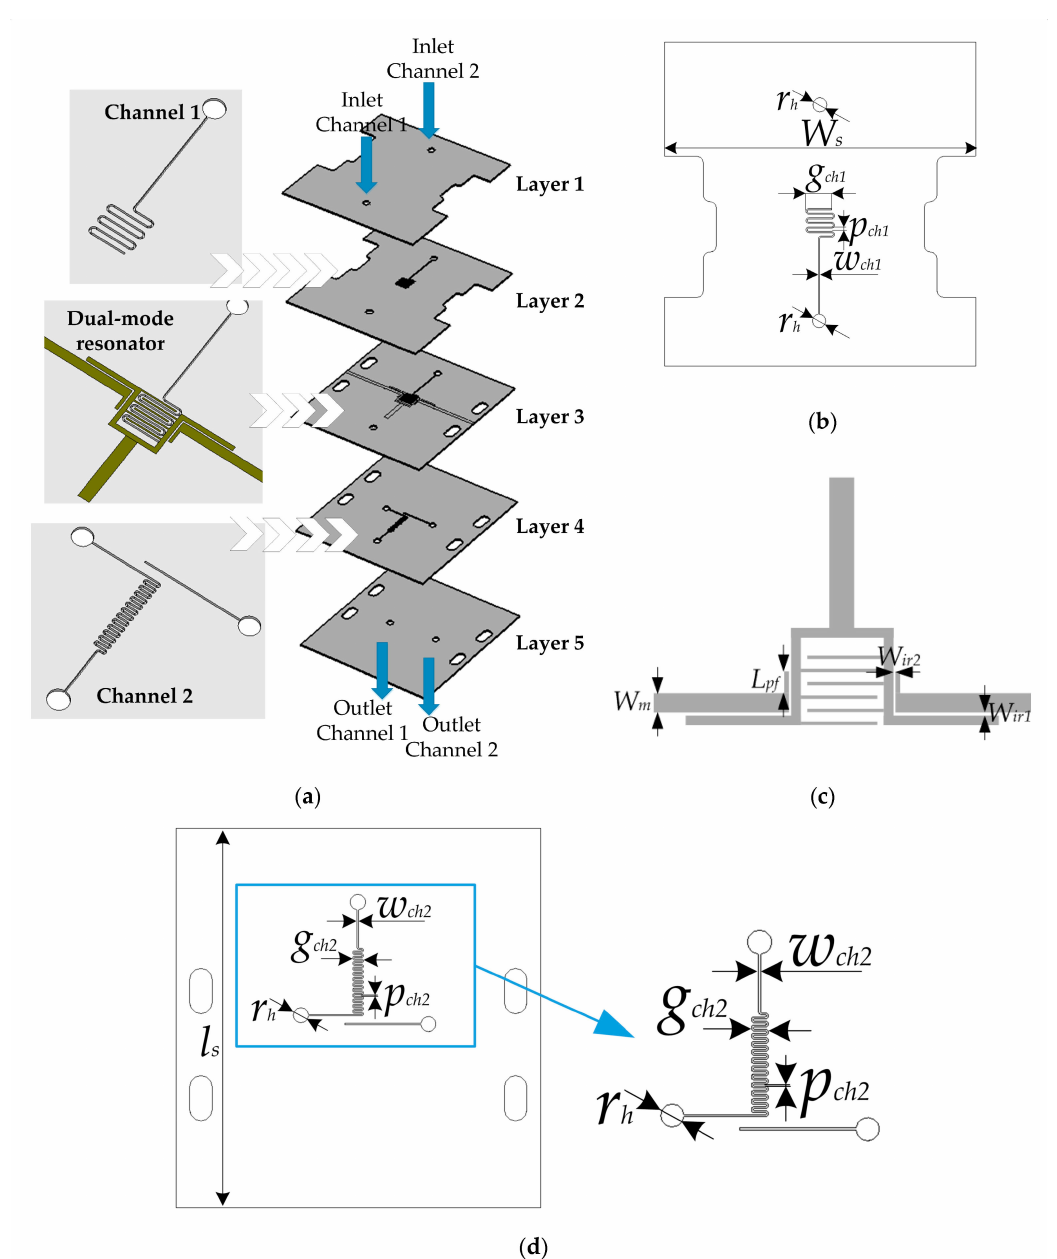
Figure 20. The layers’ geometries ( a ), the scheme of layer 2 with microchannel ( b ), the scheme of layer 3 with the capacitance resonator ( c ), and the scheme of layer 4 ( d )